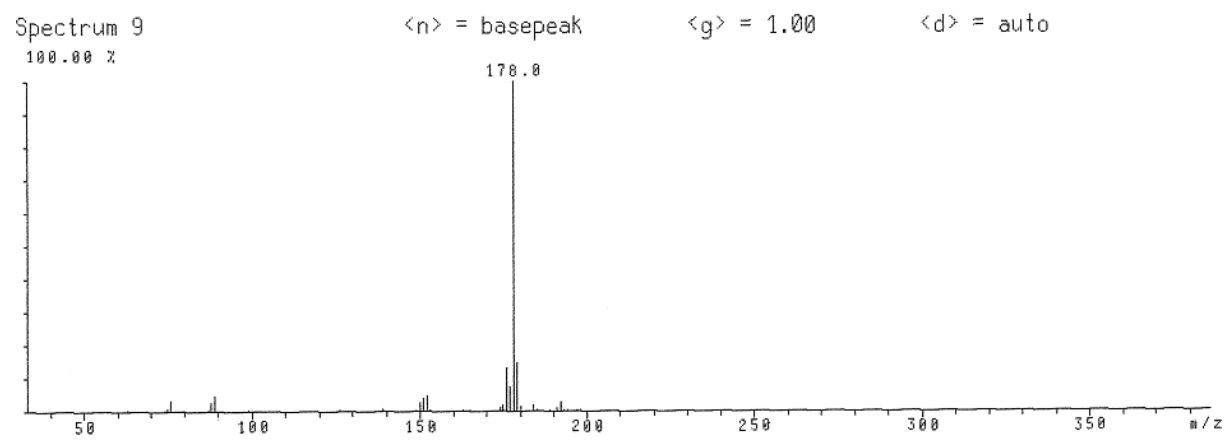
Figure 2. Gas chromatography with mass spectrometry data of freitalite from Freital. The spectrum corresponds completely to the spectrum of synthetic anthracene (NIST Chemistry WebBook, 2018a).